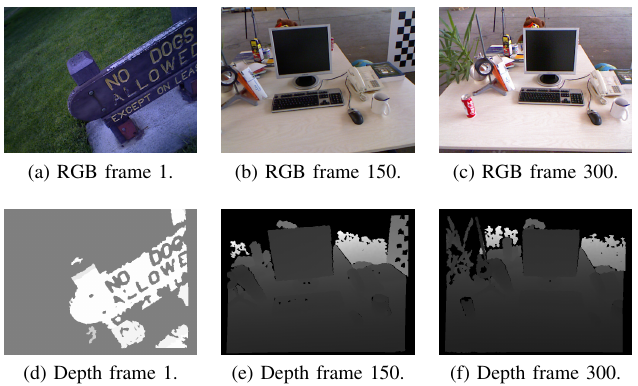
Fig. 4: (a)-(d) Sample from the sequence #03118 , showing the RGB frame and its respective depth data (source [44]). (b)- (e) RGB and depth fields for frame sequence ‘freiburg2 xyz’ (source [14]). (c)-(f) RGB and depth information for video ‘freiburg2 rpy’ (source [14]).